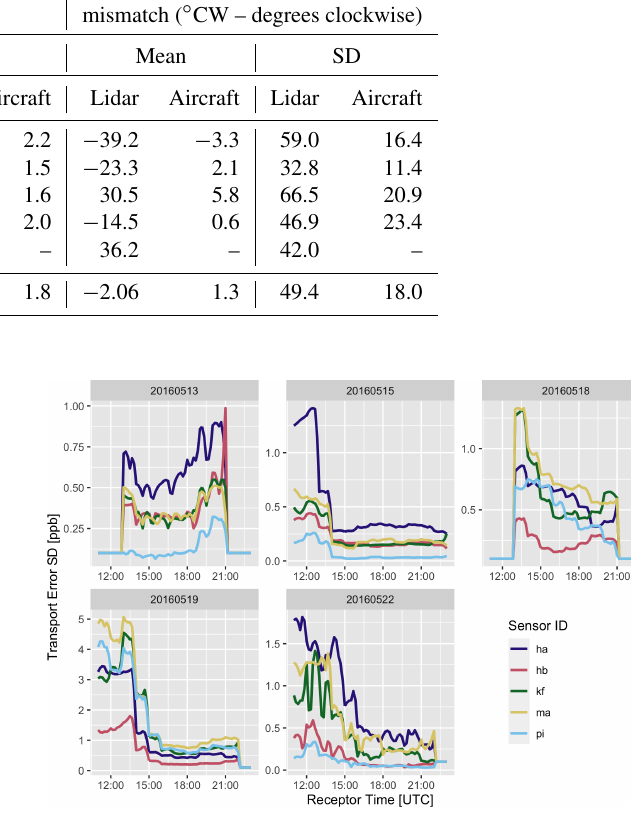
Figure 7. Likelihood of point-source contribution for each site throughout the campaign. The threshold level, 50%, is shown by the dashed line.